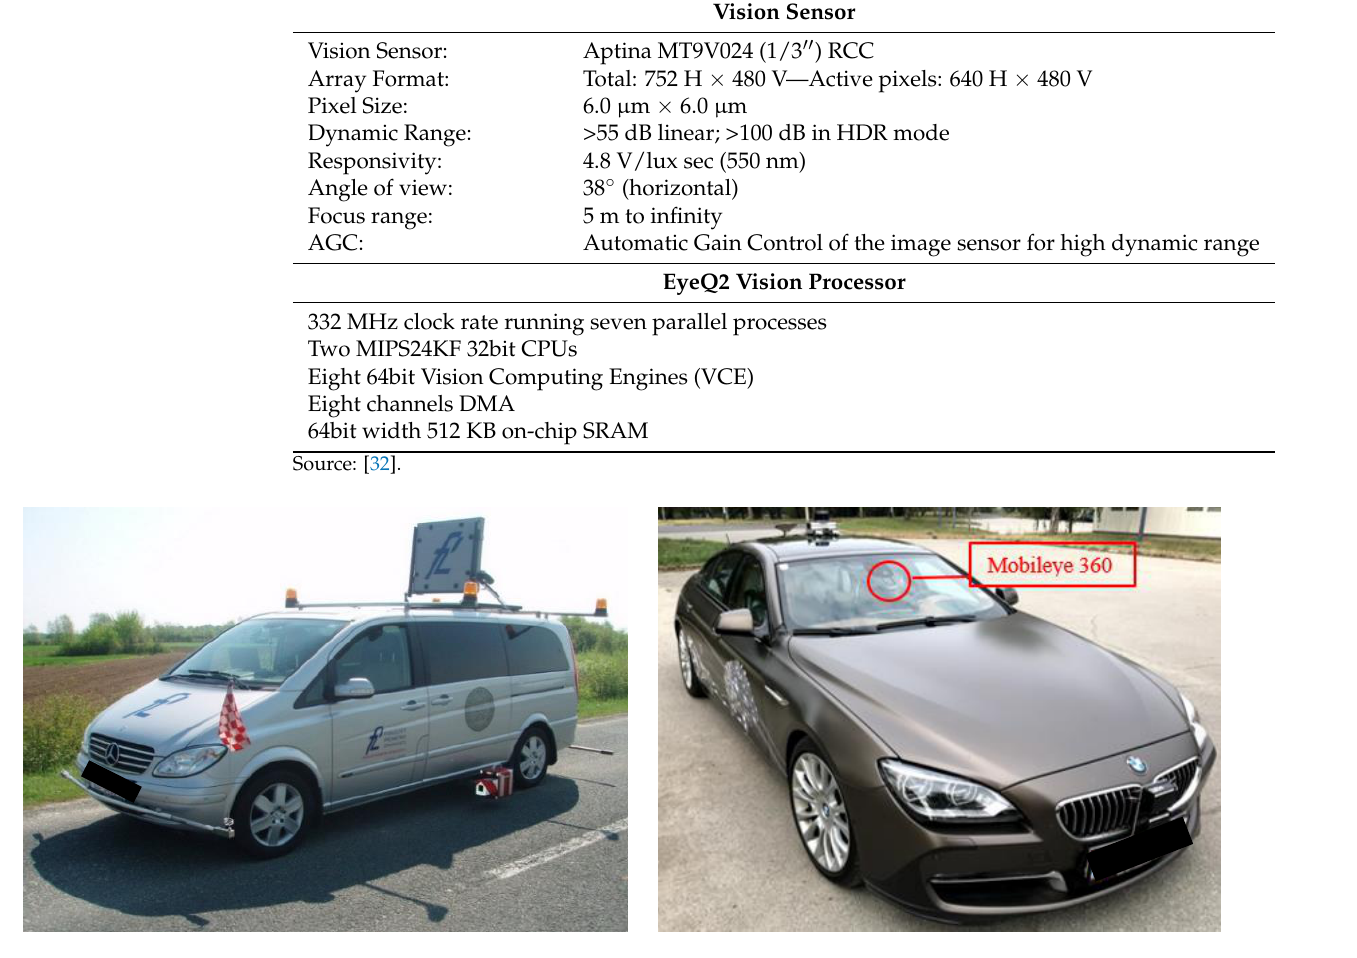
Figure 1. Testing vehicles equipped with measuring devices: dynamic retroreflectometer Zehntner ZDR 6020 ( left ) and Mobileye 360 ( right ).